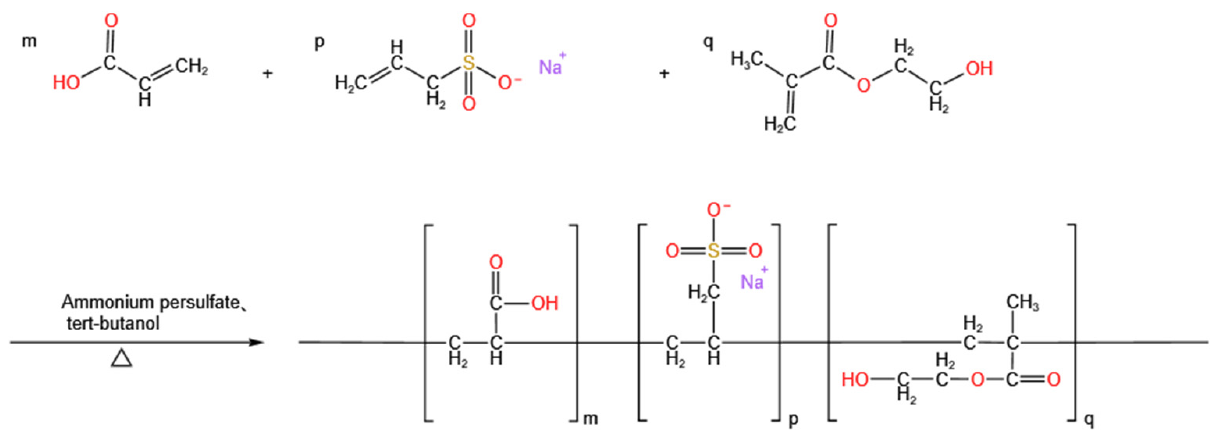
Figure 1. Synthesis process of HEMA-AA-SAS.